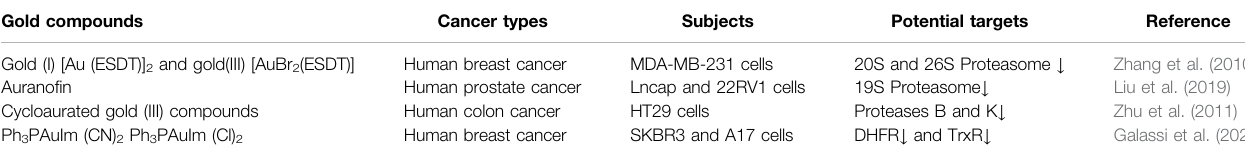
TABLE 3 | Gold compounds inhibit tumor cell growth by acting on proteasomes or by inhibiting nucleic acid synthesis. Gold